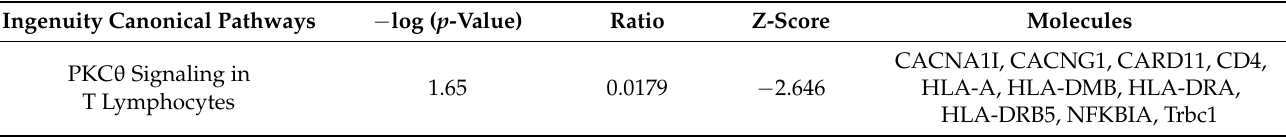
Table 1. Canonical pathways identified from protection of GM–SELP in a RIP